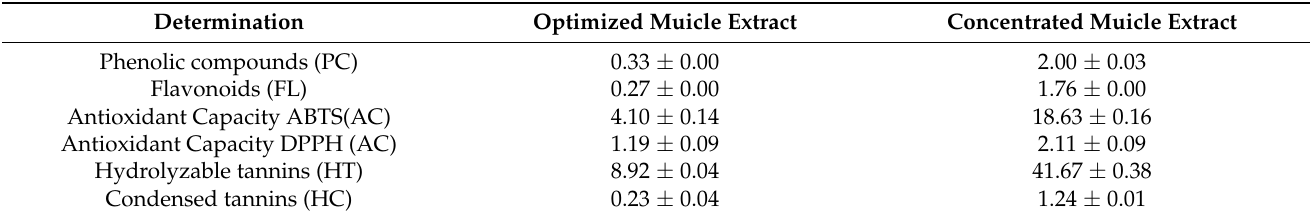
Table 2. Bioactive compounds in optimized muicle extract and concentrated extract. Determination Optimized Muicle